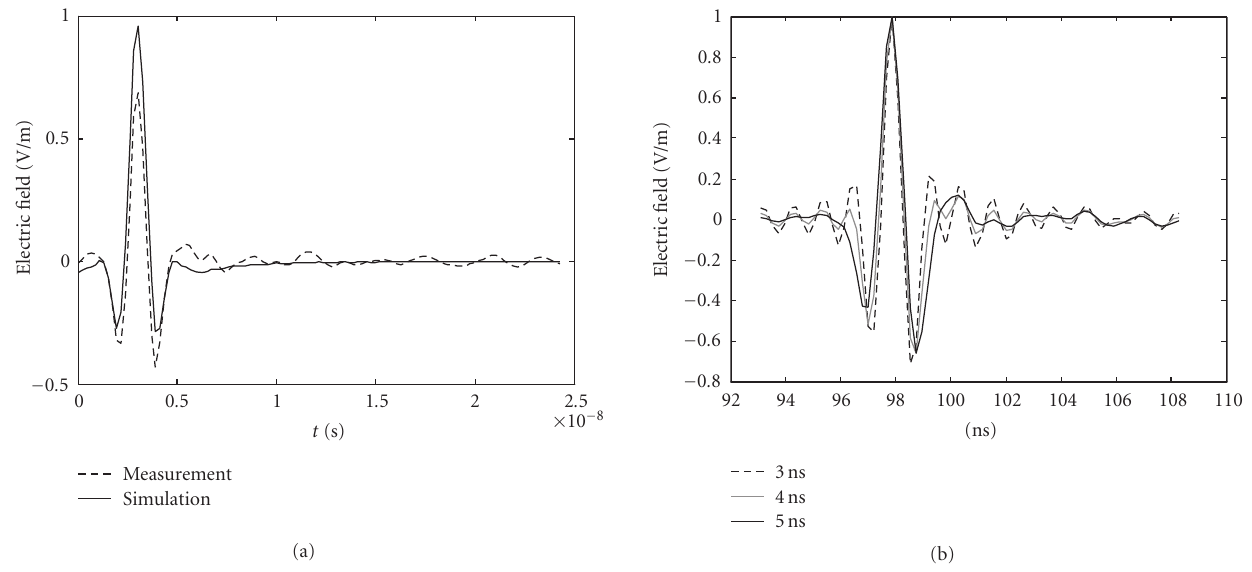
Figure 12: Transmitted waveform measurement (a) comparison between simulation and measurement results, (b) comparison of transmitted waveforms with di ff erent excitation pulses.